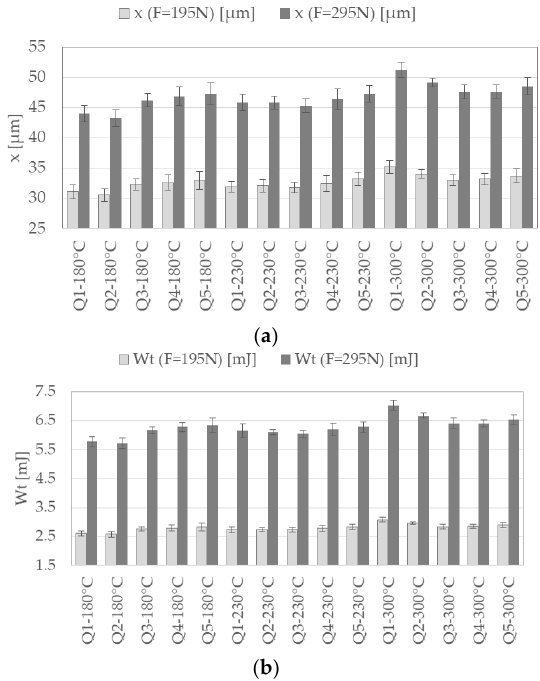
Figure 7. Descriptors of micro compression tests of the investigated heat treatment conditions of 100Cr6 extracted from force–displacement curves and ordered by annealing temperature: ( a ) Displacement x at a loading of F = 195 N and F = 295 N; ( b ) mechanical work W t at a loading of F = 195 N and F = 295 N.